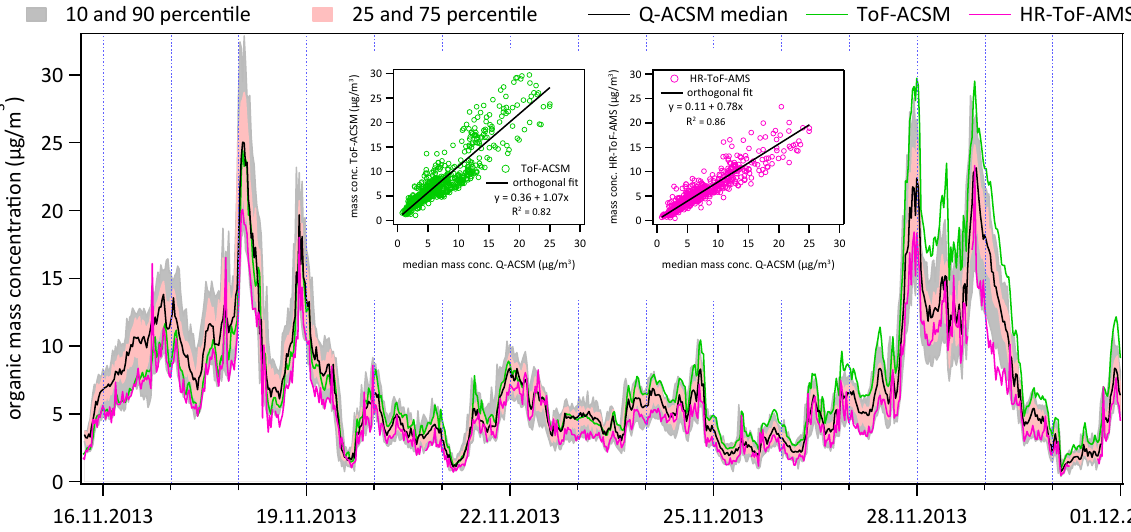
Figure 1. Time series of bulk organic matter for all 15 instruments in µgm − 3 (CE = 0 . 5, RIE org = 1 . 4). The green trace shows organic matter measured by the ToF-ACSM, the pink trace HR-ToF-AMS organic matter and the black trace the median of organic matter measured by the 13 Q-ACSMs. Since all ACSMs run with slightly different time steps all data shown in this plot had to be re-gridded to the same 30min timescale for the calculation of median and inter-percentile ranges. The light red and light grey regions indicate the 25–75 percentile range and the 10–90 percentile range of the Q-ACSM measurements, respectively. The two small insets show the correlation between ToF-ACSM and median Q-ACSM organic (green) and the same for HR-ToF-AMS and median Q-ACSM (pink). Slopes and coefficients of determination of an orthogonal distance regression are given in the plots. Average organic matter concentrations during the whole period were 6.9µgm − 3 .